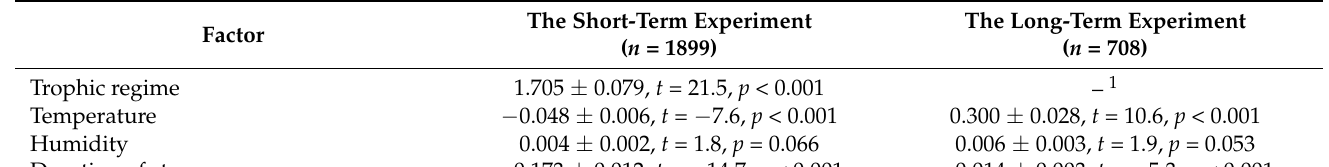
Table 1. Influence of the trophic regime, temperature, humidity, and duration of storage on the survival of Cheilomenes propinqua females (the results of the binary probit analysis: the regression coefficient ± SE, t -ratio, and significance of influence).